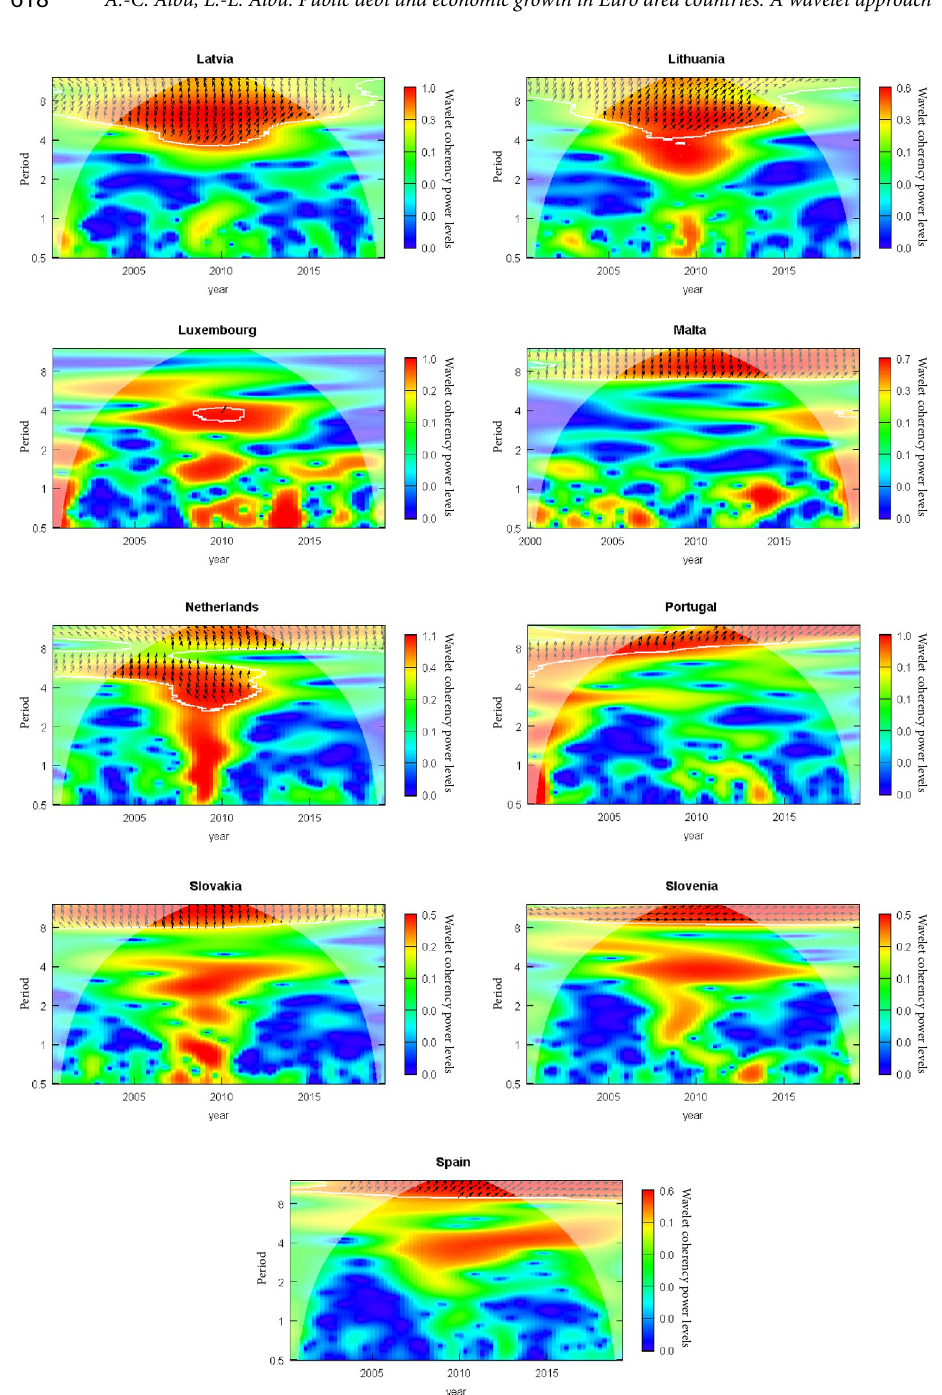
Figure 3. Wavelet coherence public debt-GDP growth for Euro Zone